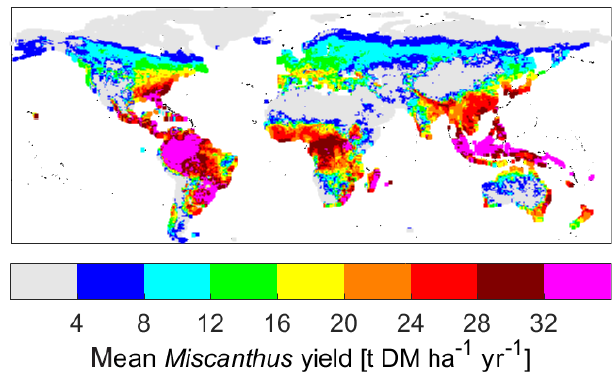
Figure 8. Bioenergy crop yield from Miscanthus under the land-use scenario RCP2.6-SSP2, compared to equivalent bioenergy yield in IMAGE (Huppmann et al.,